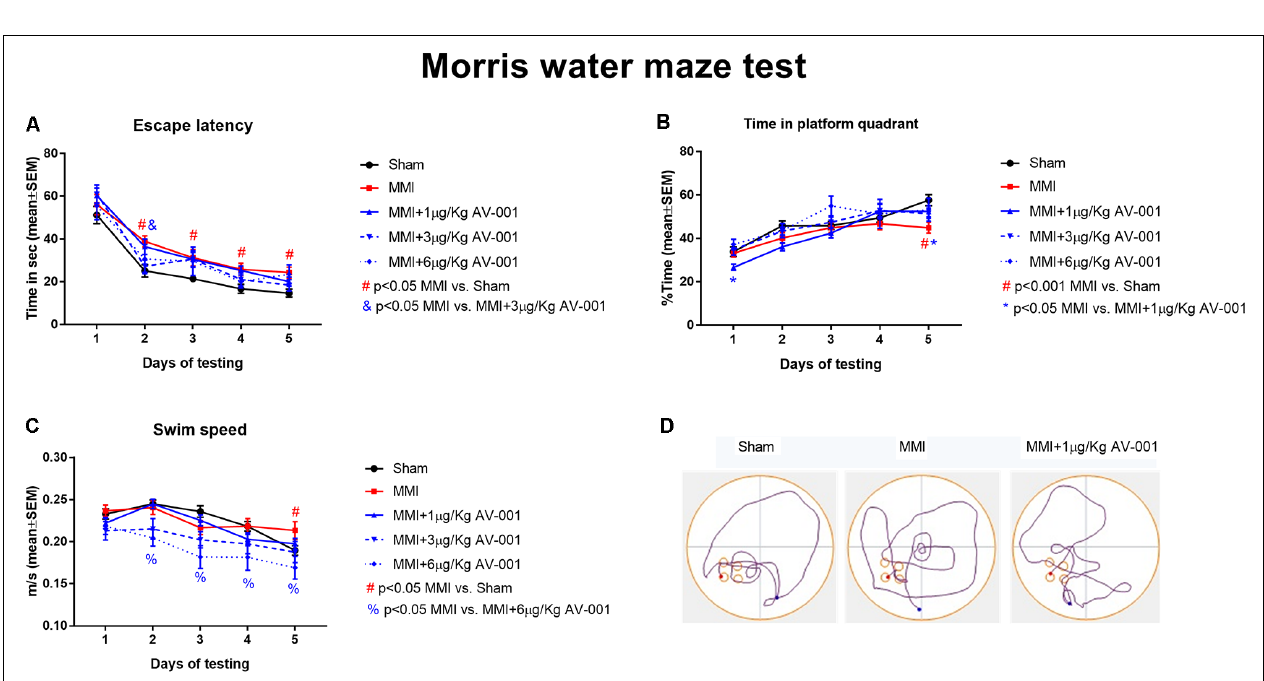
FIGURE 3 | AV-001 treatment significantly improves spatial learning and memory in middle-aged rats subjected to MMI. (A,B) In the Morris water maze test, rats subjected to MMI exhibit significant spatial learning and memory impairment indicated higher escape latency and lower percentage of time exploring the platform quadrant compared to Sham control rats. Treatment with 1 µ g/Kg AV-001 significantly increases the time spent exploring the platform quadrant on day 5 of testing compared to control MMI rats indicating improved cognition. (C) Rats subject to MMI and treated with 6 µ g/Kg AV-001 exhibit significantly lower swim speeds compared to control MMI rats. (D) Representative track plots of day 5 of